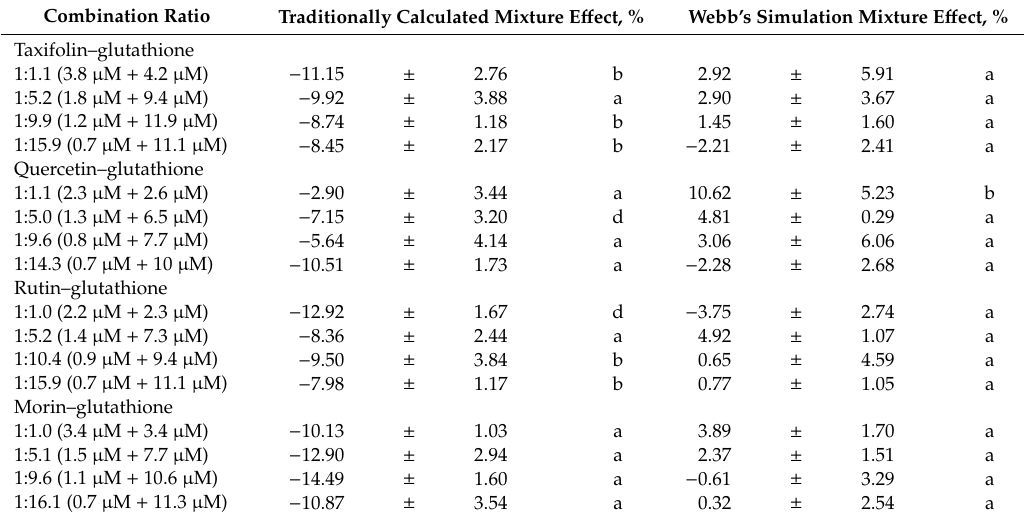
Table 2. Antioxidant mixture e ff ects of the flavonoid–glutathione combinations in the decolorization assay. Combination Ratio Traditionally Calculated Mixture E ff ect, % Webb’s Simulation Mixture E ff ect,